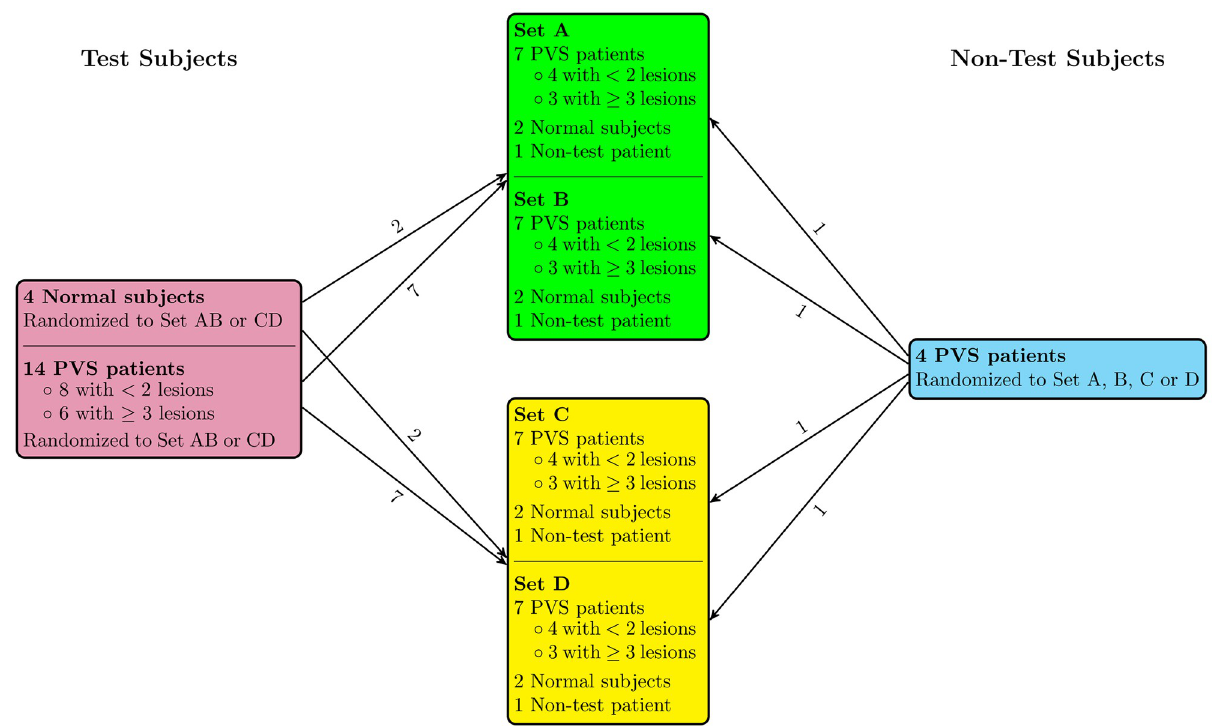
Fig 2. Distribution of cases into test sets. Cases of pulmonary vein stenosis (PVS) distributed into 4 test sets, A, B, C or D. Sets A and B have the same test cases. Sets C and D have the same test cases.